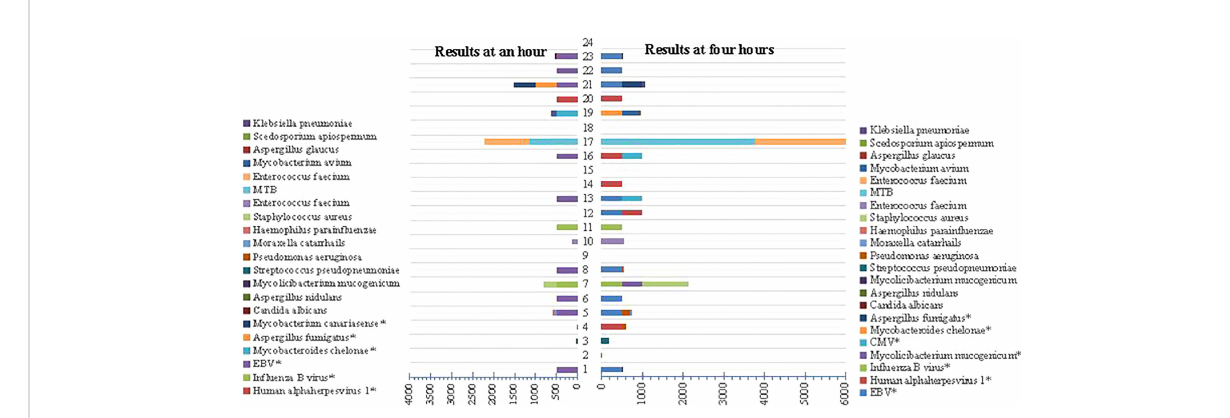
FIGURE 8 Comparison of genus distribution at an hour and 4 hours using Nanopore technology. “ * ” represents targeted sequencing detection